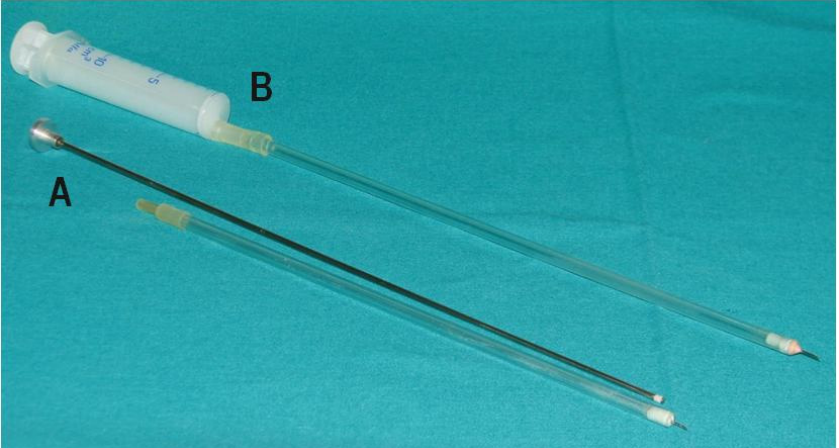
Figure 3. Tools for oocyte aspiration. A—originally designed 1 mL syringe for oocyte aspiration with a needle (needle: 1 cm long and 0.6mm diameter, 23 G; Polish Patent Application P-361068, 2003) (Variants I and II), B—catheter for oocyte aspiration (Variants III and IV).